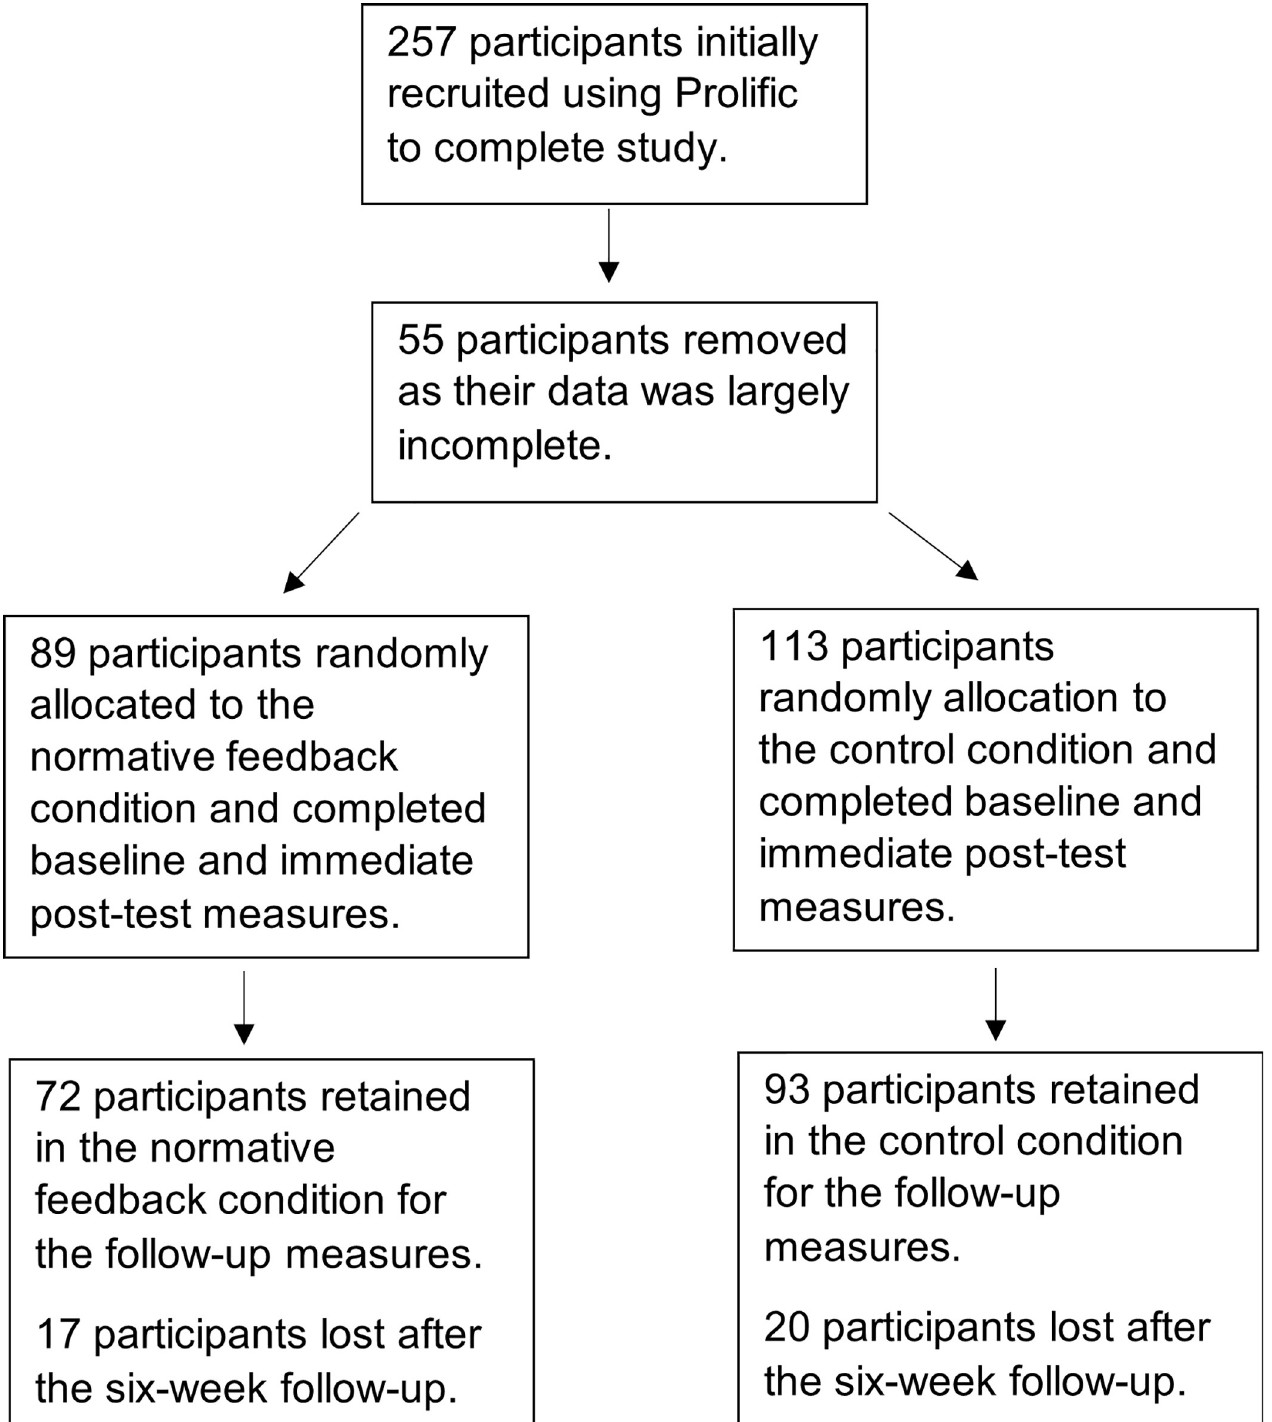
Fig 1. Flow-chart showing the number of participants in each stage of the study.